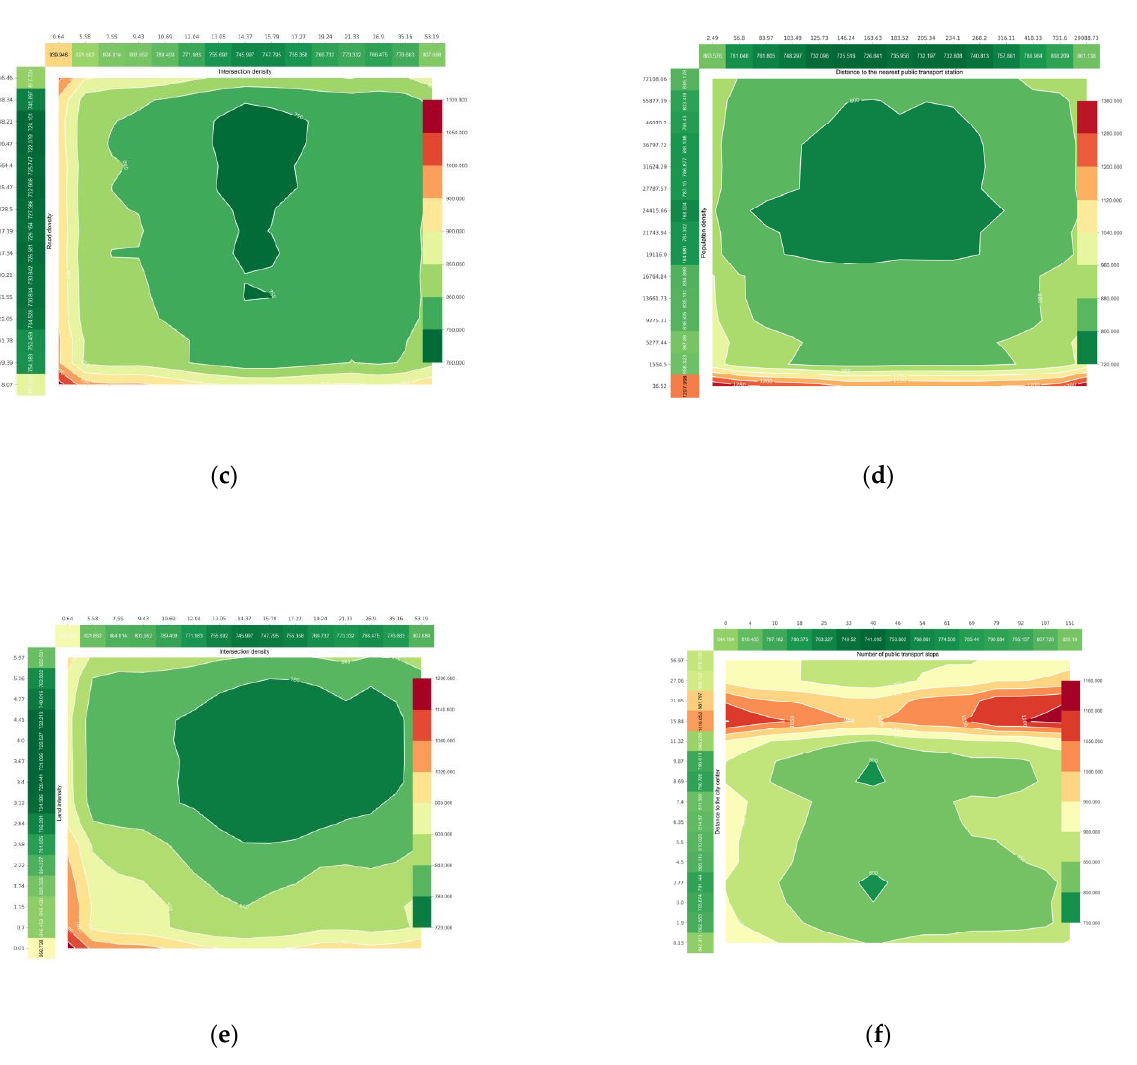
Figure 10. Synergistic effects among other built environment variables. ( a ) Synergy of land intensity and the distance to the city center; ( b ) Synergy of land intensity and the number of public transit stations; ( c ) Synergy of road network density and intersection density; ( d ) Synergy of population density and the distance to the nearest station; ( e ) Synergy of land intensity and intersection density; ( f ) Synergy of the distance to the city center and the number of public transit